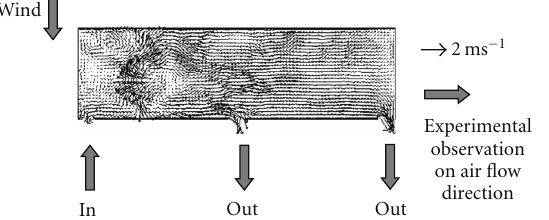
Figure 6: Predicted velocity vector across a plane with vents for Case 2.